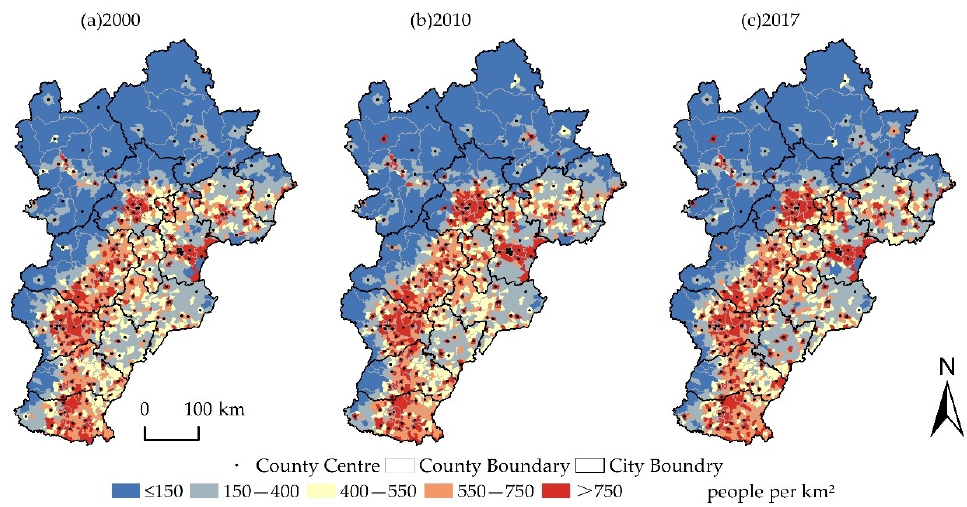
Figure 3. Distribution pattern of population density in the Beijing–Tianjin–Hebei region from 2000 to 2017.